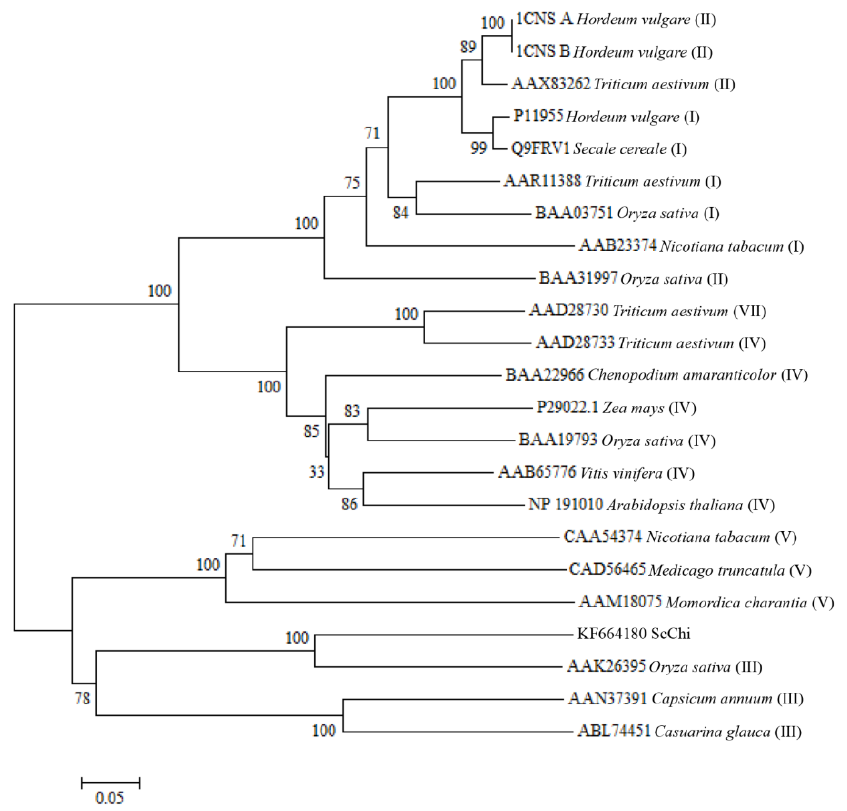
Figure 3. Phylogenetic analysis of deduced amino acid sequence from ScChi (KF664180) and other plant chitinases. The neighbor-joining method was used. Plant chitinase classes are represented in